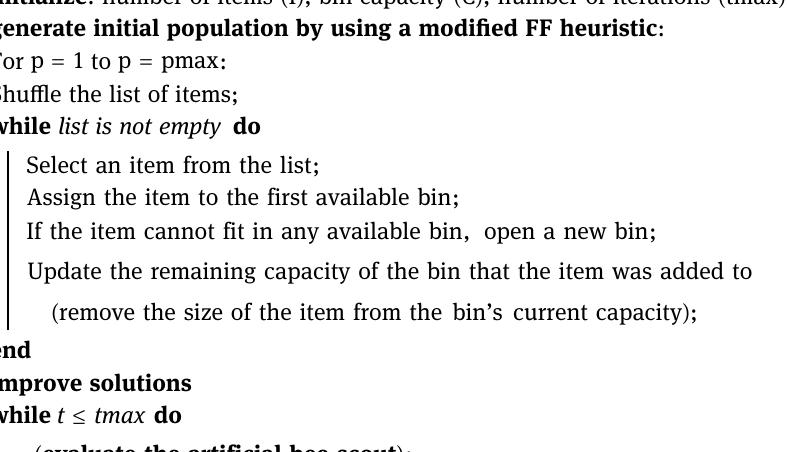
Algorithm 1 : Pseudocode of adaptive fi tness dependent optimizer